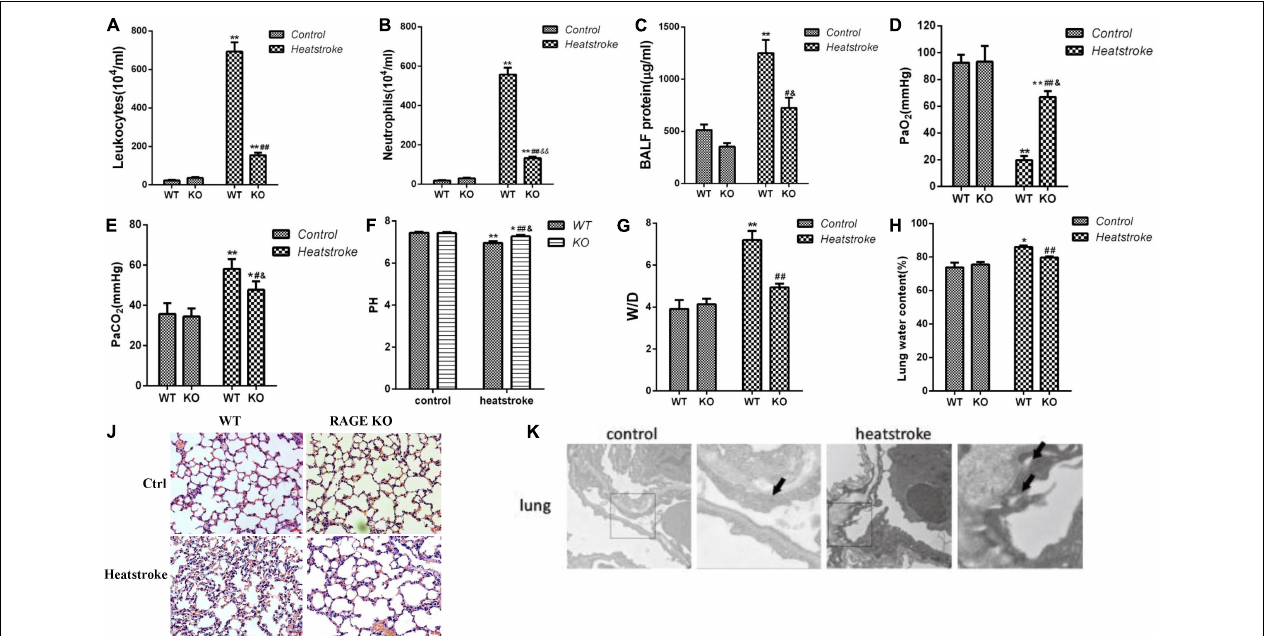
FIGURE 1 | Knockout of the RAGE gene played a protective role in acute lung injury induced by heatstroke in mice. Mice were placed in an artificial climate chamber with an environment temperature of 37 ± 0.5 ◦ C and relative humidity of 60% ± 5%. Immediately after Tc reached 42.7 ◦ C, animals were taken out of the chamber and allowed to recover at room temperature for 2 h. (A–C) The leukocytes, neutrophils, and protein concentration in BALF, (D,E) Arterial blood gas parameters, (G,H) Lung wet/dry ratio, and water content were measured ( n = 3, * P < 0.05, ** P < 0.01 vs WT control group; # P < 0.05, ## P < 0.01 vs WT heatstroke group; & P < 0.05, && P < 0.01 vs KO control group). (J) Histopathological changes in lung tissue for RAGE gene knockout mice suffered from heatstroke. The heat stressed mice displayed swelling of the alveolar epithelial cells, thickened alveolar wall, telangiectasia, and inflammatory cell infiltration in the alveolar interstitium. The knockout of the RAGE gene significantly attenuated histopathological changes in the lung tissue of heatstroke mice. (K) Morphological ultrastructure in lung tissue for mice of the control group ( n = 3) and heatstroke group ( n = 3). Images were obtained by electron microscopy. Arrows indicate intercellular junctions. Junctions between interconnecting cells were integral in the control group while heat exposure resulted in the disruption of intercellular